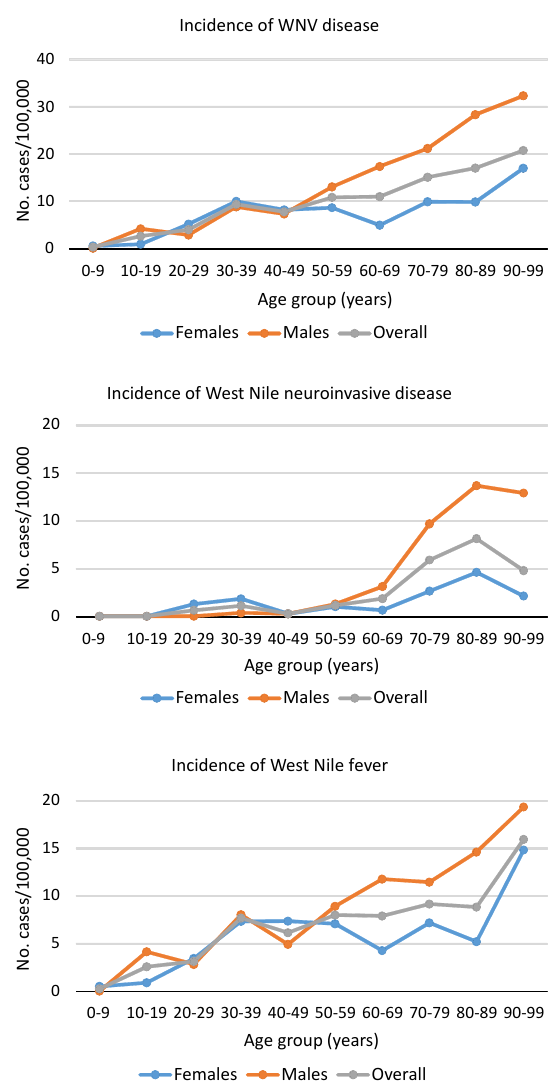
Figure 1. Incidence of WNV disease (i.e., West Nile neuroinvasive disease and West Nile fever), incidence of West Nile neuroinvasive disease, and incidence of West Nile fever according to age and sex, Veneto region, northern Italy, 2018. Data on the population resident in the Veneto region were obtained from ISTAT (Italian Institute of Statistics,